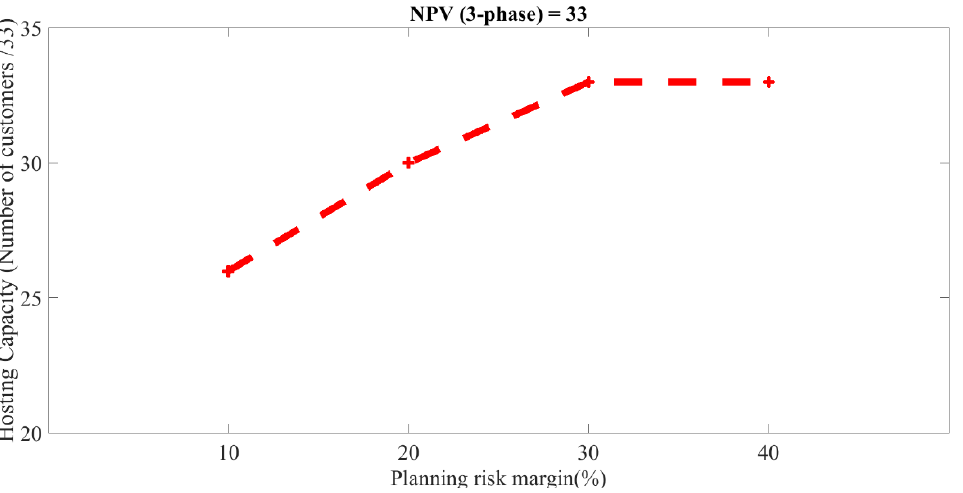
Figure 7. The hosting capacity estimations for the different less strict planning risks of a DSO.